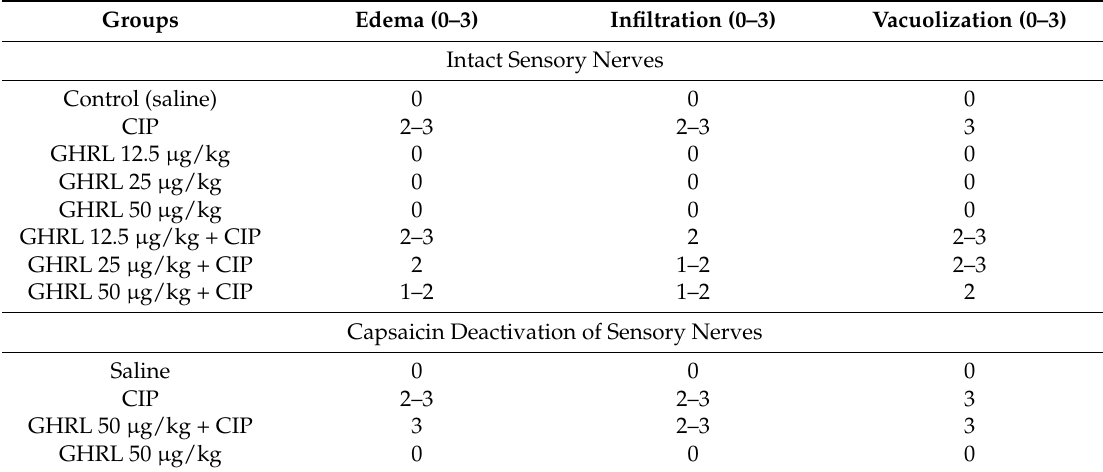
Numbers represent the predominant histological grading in each experimental